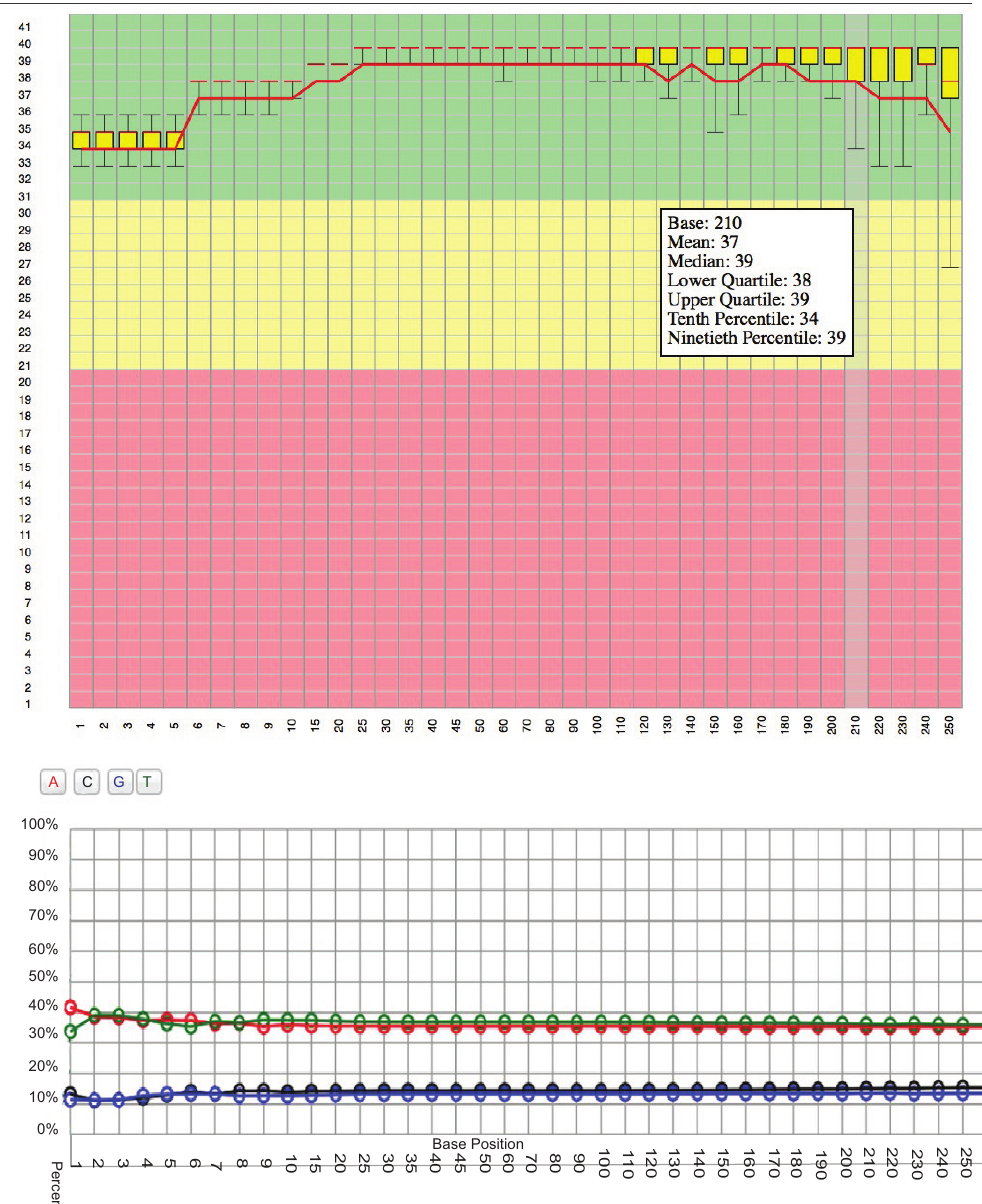
Figure 6. Examples of d3.js plots, generated from FastQC data parsed into